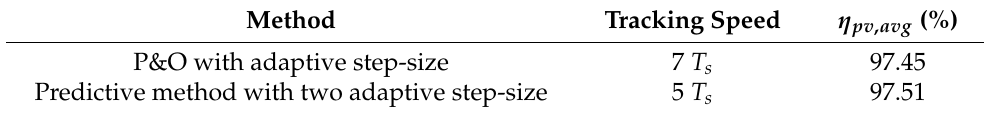
Table 3. Tracking speed and average efficiency of the MPPT